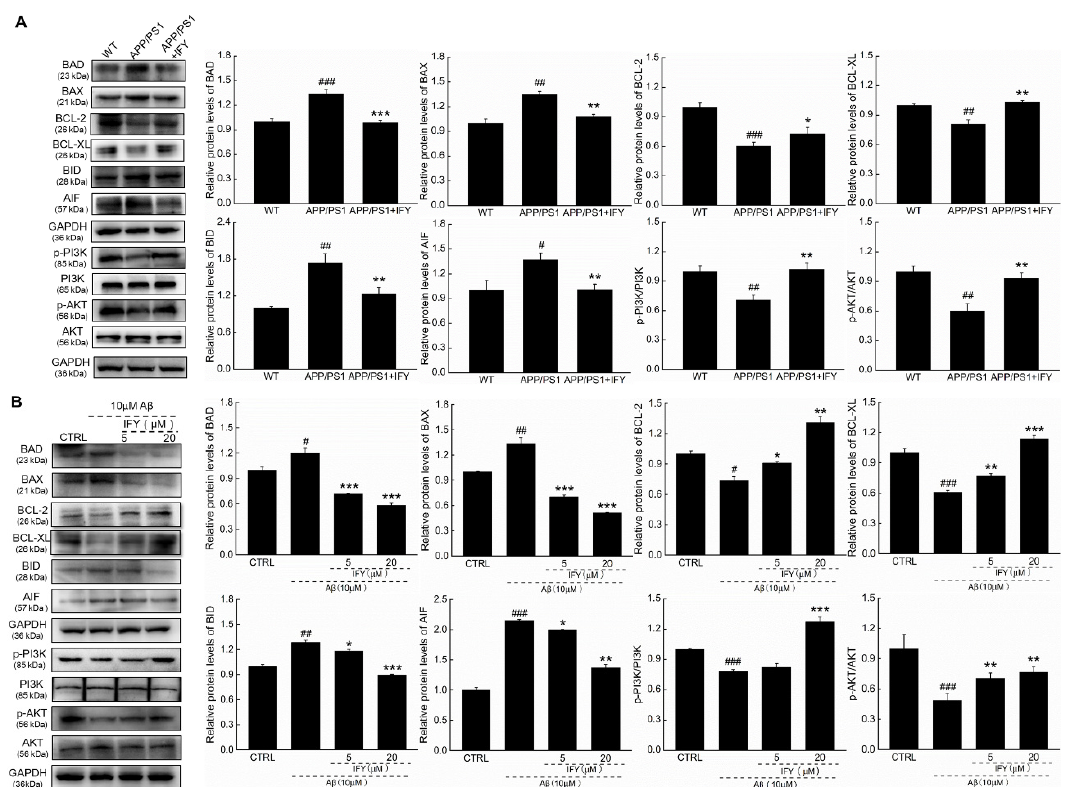
Figure 5. IFY regulated the expression levels of mitochondrial apoptosis-related proteins. IFY ameliorated the expression levels of apoptosis related proteins including BAD, BAX, BCL-2, BCL-XL, BID, AIF, p-PI3K and p-AKT in ( A ) the hippocampus of APP / PS1 mice and ( B ) A β 1-42 -exposed U251 cells. Quantification data were normalized by glyceraldehyde-3-phosphate dehydrogenase (GAPDH) and the corresponding total proteins, and are reported as the percentage of those from the corresponding CTRL ( n = 3). Data are shown as the mean ± SEM. # p < 0.05, ## p < 0.01, ### p < 0.001 vs. WT mice (CTRL cells), * p < 0.05, ** p < 0.01, *** p < 0.001 vs. APP / PS1 mice (A β 1-42 -exposed U251 cells).